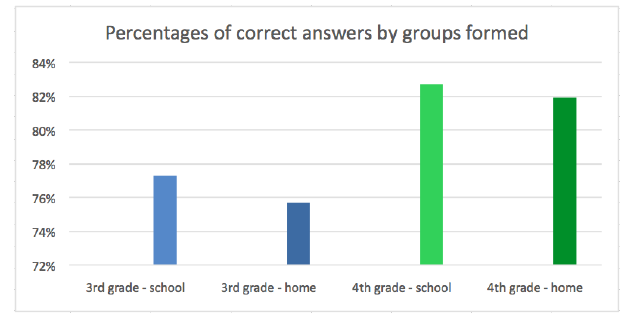
Figure 8. Evolution of the number of correct answers during the fifteen sections.